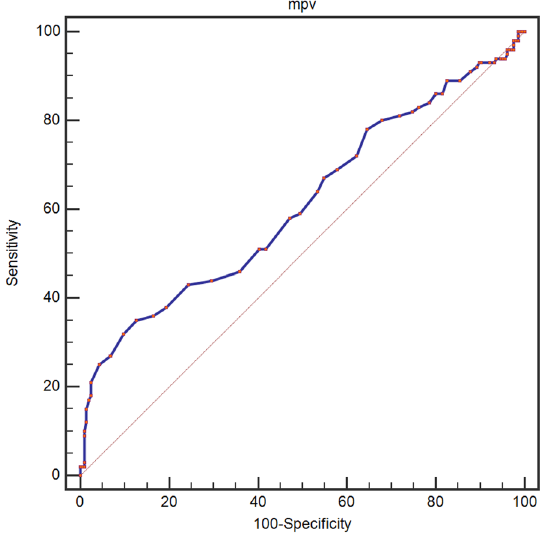
Figure 1. Optimized cut-off was determined for MPV using standard ROC curve